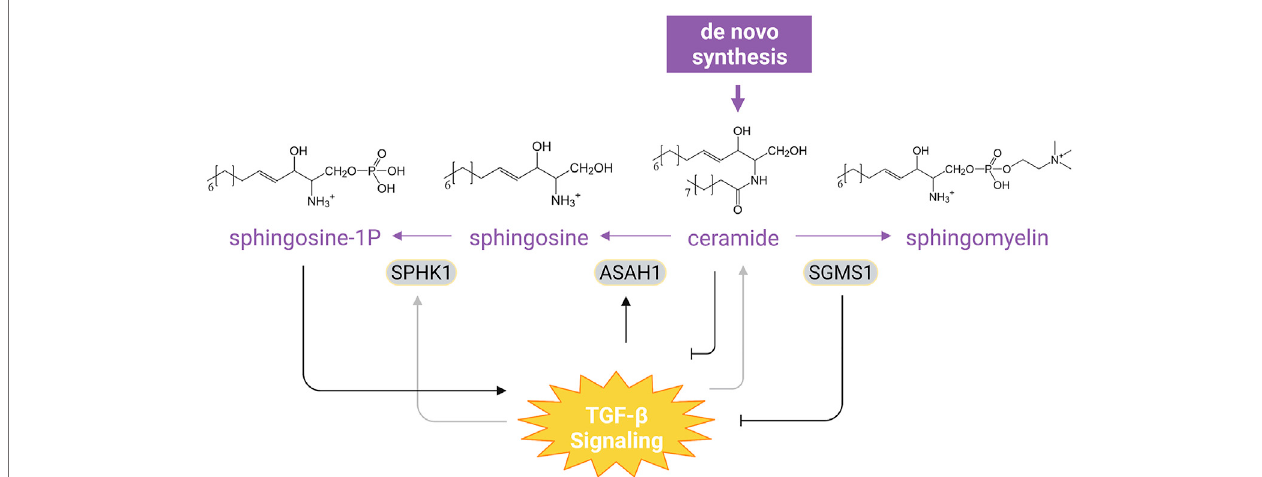
FIGURE3| InteractionofTGF- β SignalingwithSphingolipidMetabolism.TGF- β differentiallyregulatesSPHK1expressioninacontext-dependentmannerandcan upregulate ASAH1 to promote aberrant accumulation of sphingosine. Ceramide, the only sphingolipid that can be de novo synthesized, has been shown to constrain TGF- β signaling.OverexpressionofSGMS1,whichcatalyzessynthesisofsphingomyelinfromceramide,alsoinhibitsTGF- β signaltransduction.Moreover,sphingosine- 1P can evoke TGF- β -like responses in cells (see text). For simplicity, synthesis of other sphingolipid and the downstream catabolism of sphingosine-1P have been omitted. Purple texts and arrows, the sphingolipid metabolic pathway; gray arrows, cell-type dependent effect. Abbreviations: SPHK1, sphingosine kinase 1; ASAH1, N-acylsphingosine amidohydrolase 1; SGMS1, sphingomyelin synthase 1. Figure is created with BioRender.com.